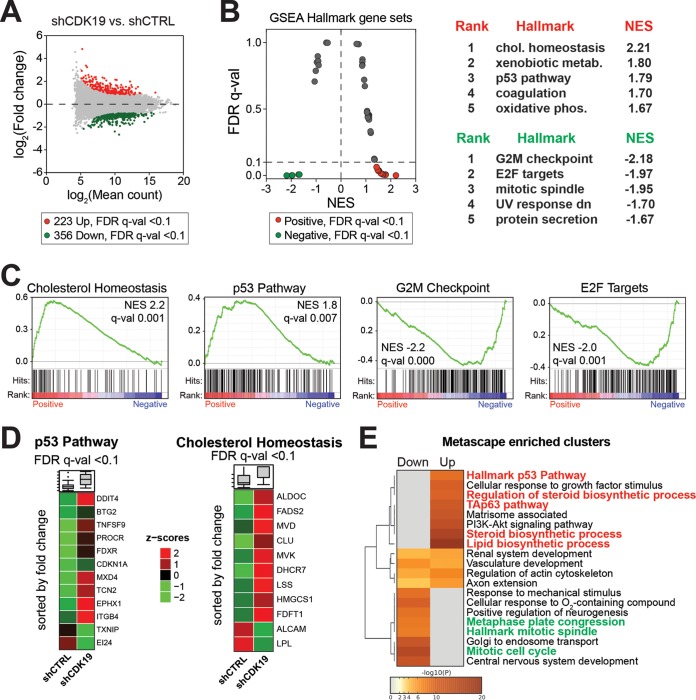
Gene expression (RNA-Seq) changes due to CDK19 knockdown affect the p53 pathway, mitosis, and cholesterol homeostasis. (A) MA plot comparing control and CDK19 knockdown SJSA cells. (B) Plot of false discovery rate (FDR) versus the normalized enrichment score (NES) based upon GSEA from RNA-Seq data (shCDK19 versus shCTRL). The dashed line represents the 0.1 FDR cutoff. Note that the p53 pathway and cholesterol homeostasis are positively enriched in CDK19 knockdown cells, whereas gene sets associated with mitosis are negatively enriched. The top five ranked positively and negatively enriched gene sets are shown on the right. (C) GSEA plots for selected hallmark gene sets, with black bars indicating gene sets represented among all genes ranked by log2-fold change (shCDK19 versus shCTRL). (D) Heat maps showing average expression, calculated from the reads per kilobase per million (RPKM), of the p53 pathway and cholesterol homeostasis genes; only genes meeting an FDR q < 0.1 threshold are shown. (E) Heat map of Metascape-enriched clusters. Each cluster contains multiple gene sets to eliminate redundancy. Analysis used genes meeting an FDR q < 0.1 threshold.